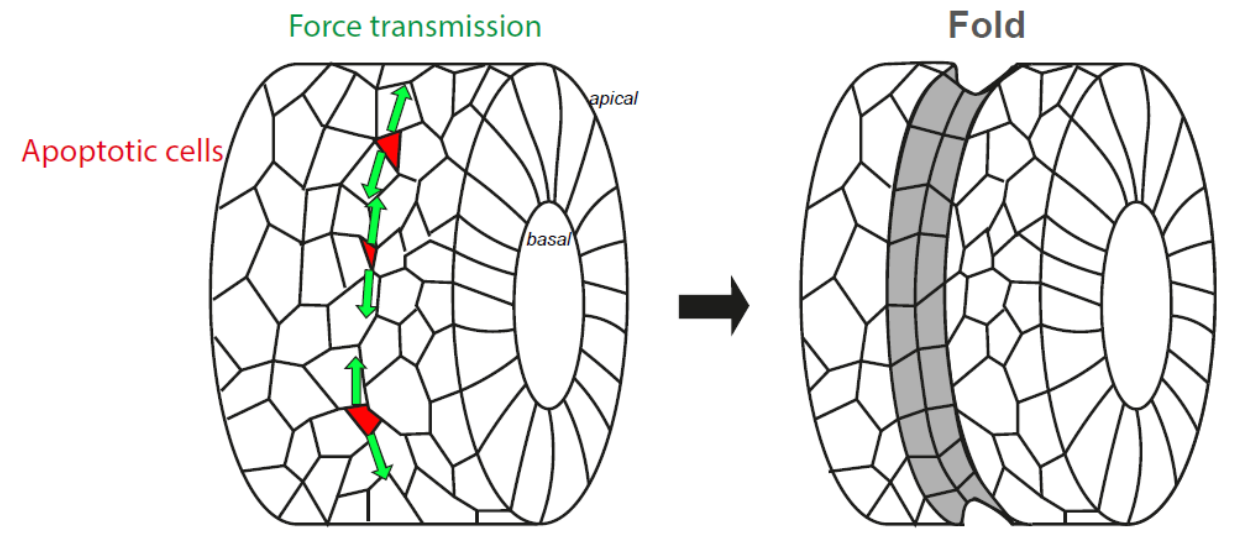
Figure 3. Impact of apoptosis on epithelium folding. Schematic representations of the Drosophila leg disc before (left) and after (right) fold formation. This tissue initially forms a cylinder and apoptotic cells are represented in red. The apoptotic forces are then produced, transmitted to the neighbouring tissue (green arrows), leading to the formation of a fold (grey).